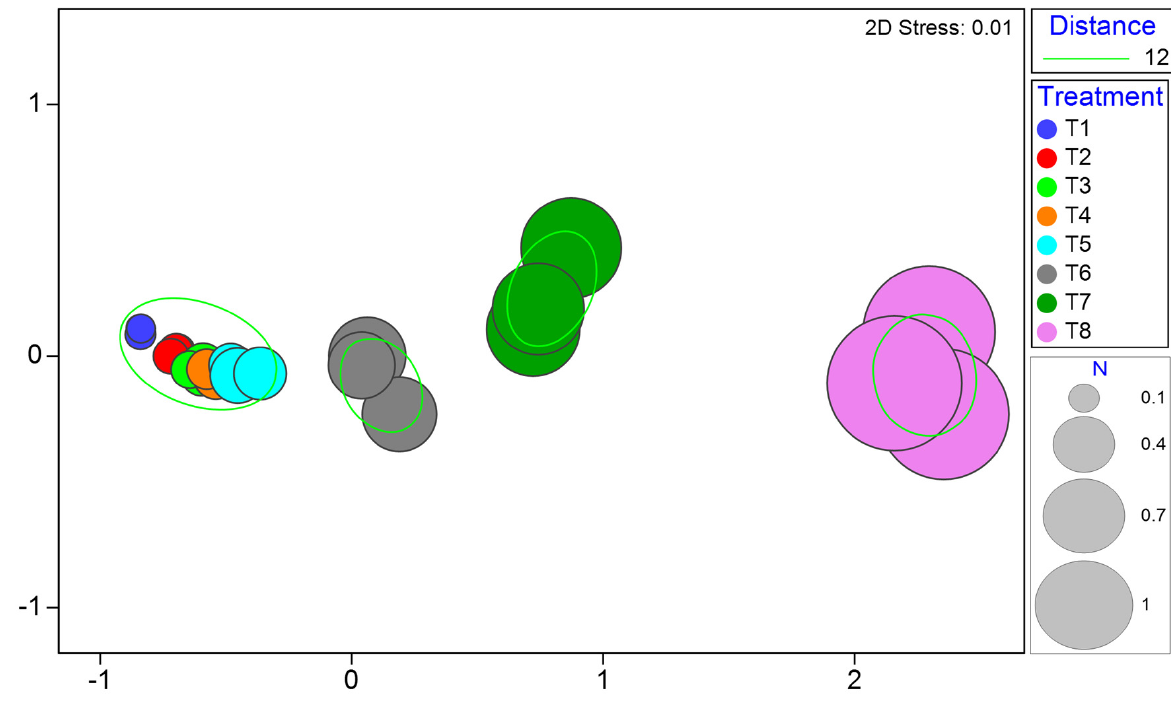
Figure 5. Non-metric multidimensional scaling (nMDS) bubble plot of Euclidian distances between the proportion of nutrients in tomato fruits in treatments receiving increasing UWP supplement rates (T1 = 0.3%; T2 = 0.5%; T3 = 0.8%; T4 = 1%; T5 = 2%; T6 = 3%; T7 = 5%), and Hoagland’s solution (T8). Samples treatments grouping are the results of an overlayed cluster analysis by group average of resemblance distance. The bubble size indicates N content (g 100 g − 1 ).